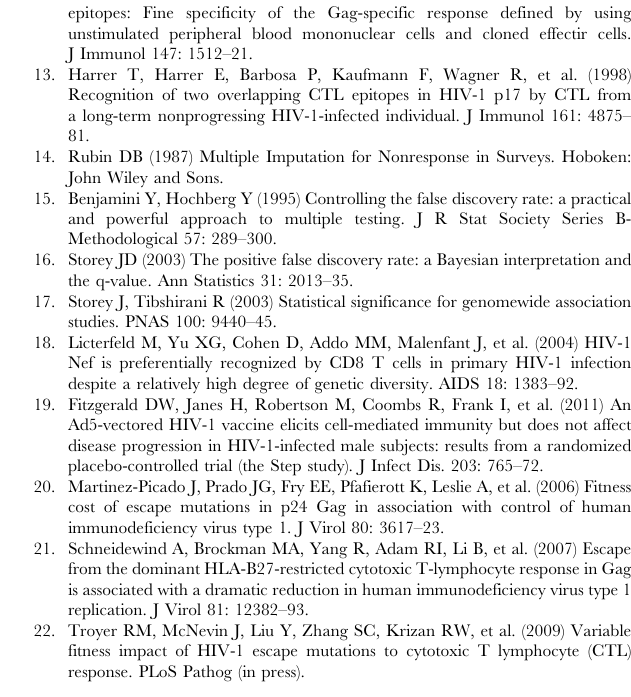
Figure S11 Association Between Acute Log 10 Viral Load and Predicted CTL Epitope Epipred Distance. The predicted CTL epitope distance between a breakthrough sequence and the MRKAd5 insert is the HIV-specific evolutionary (PAM) distance in peptides predicted to be epitopes in both sequences (based on Epipred), averaged over a subject’s breakthrough sequences. Missing viral load values were multiply imputed and represent averages across 20 datasets; solid points are observed values and open points are averages across 20 imputations. The Pearson correlation (r) is shown for vaccine (red circles; dashed line) and placebo (green squares; solid line) groups. Fitted lines from linear regression models are overlaid. Table S1 List of the 32 peptides covering the signature sites that were assessed using IFN c